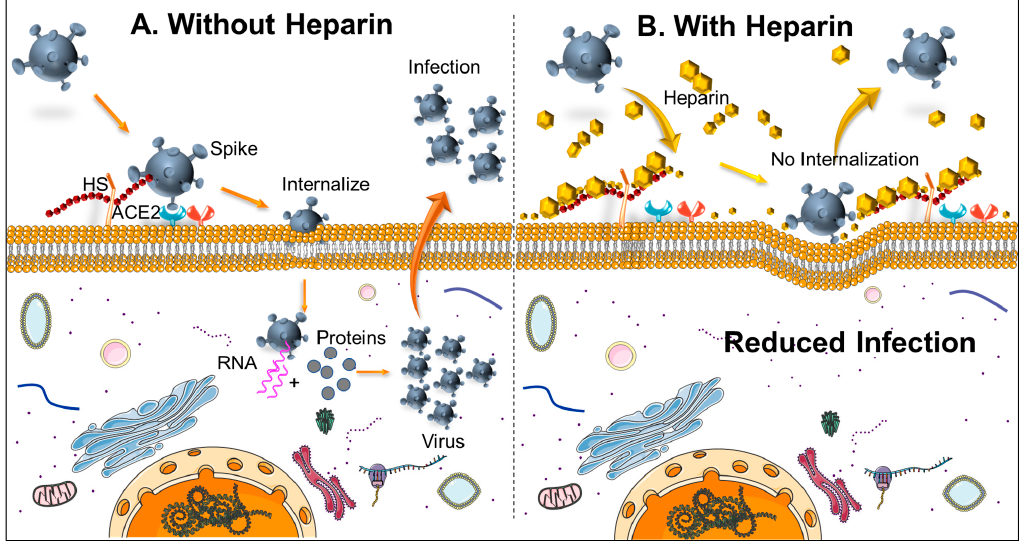
Figure 1. Schematic showing ( A ) In the absence of Heparin, SARS-CoV-2 receptor binding domain of spike glycoprotein interacts with heparan sulfate (HS) and can facilitate virus internalization through ACE2. As a result, viral components replicate inside the cell and finally are released to increase the infection to the neighboring cell, ( B ) in the presence of heparin, the accessibility to heparin sulfate proteoglycan is decreased, and hence the virus is not able to internalize, which results in a decrease in virus binding to the cell surface.